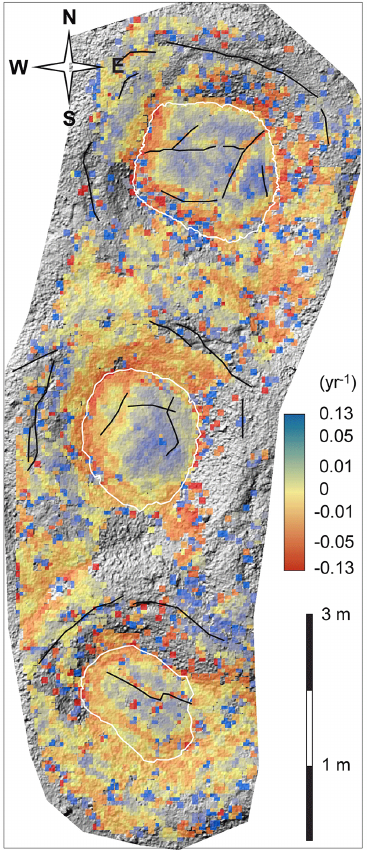
Figure 11. Sum of horizontal strain rates from the 2007–2010 dis- placement field. Computation has been based on the filtered dis- placement field (Fig. A1; see Appendix) and further filtered based on residuals of a redundant strain rate algorithm (see text). Blue colouring indicates horizontal extension (divergence); red indicates compression (convergence). The fine–coarse boundary is indicated in white, and the cracks in black. Note that, in order to highlight variations, the colour scale of strain rates is not linear. Background: hillshade of